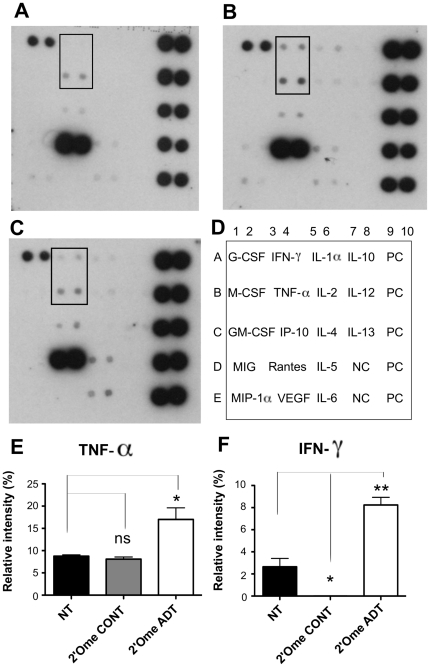
Profile of cytokine expression in C4HD cells treated with siRNAs targeting IGF-IR.Cytokine secretion in untreated C4HD cells (C) or C4HD cells transfected with 2′-O-methyl CONT2 (A), or 2′-O-methyl ADT (B) were analyzed 48 h post-transfection using a mouse cytokine antibody array (D). PC, array positive controls; NC, array negative controls. Graphs corresponded to densitometric analysis of membranes for TNF-α and IFN-γ expression (E, F). * P<0.05; ** P<0.01. Two independent cytokine antibody arrays were performed and gave similar results.